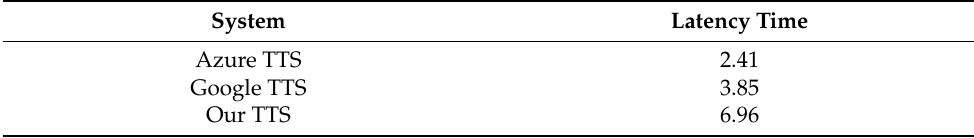
Table 9. Inference speed